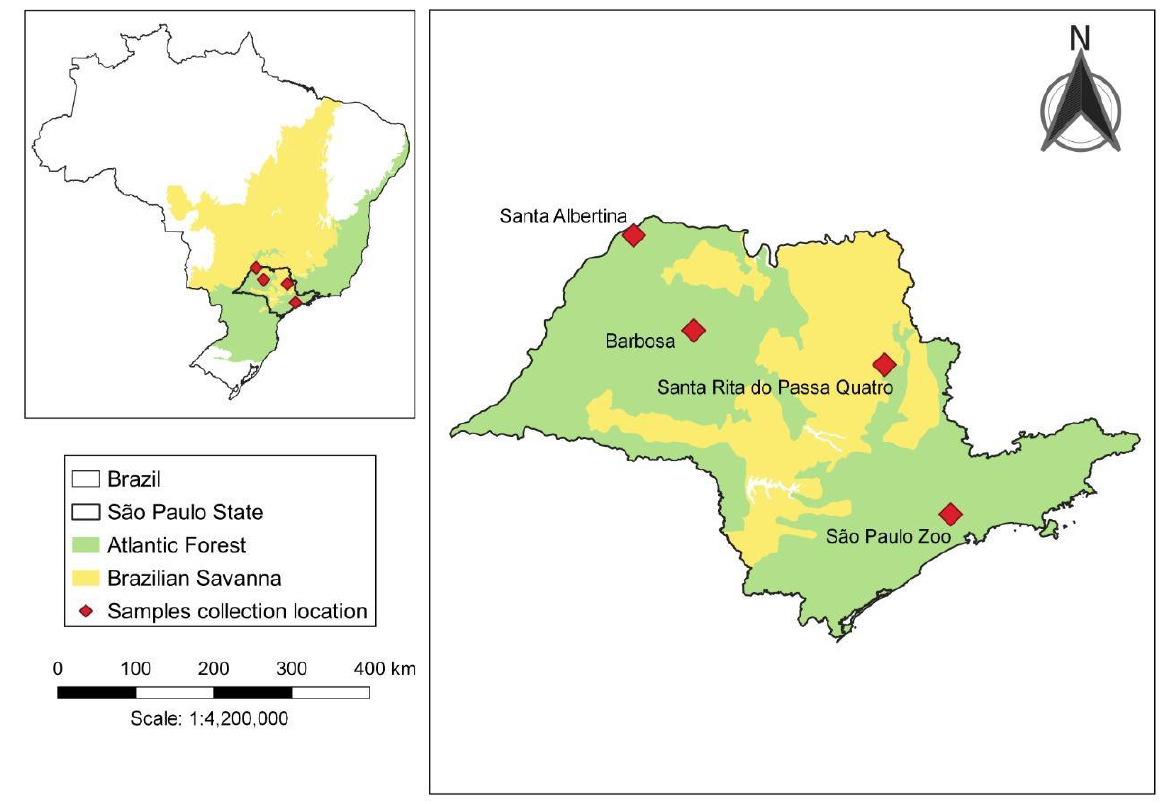
Figure 1. Location of municipalities in the State of São Paulo, Brazil, where Mansonia specimens were collected.